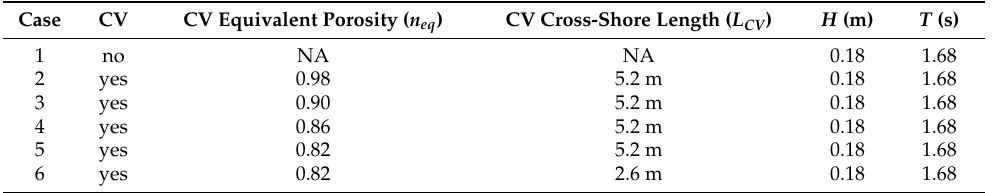
Table 1. Vegetation and wave parameters for all simulated cases.